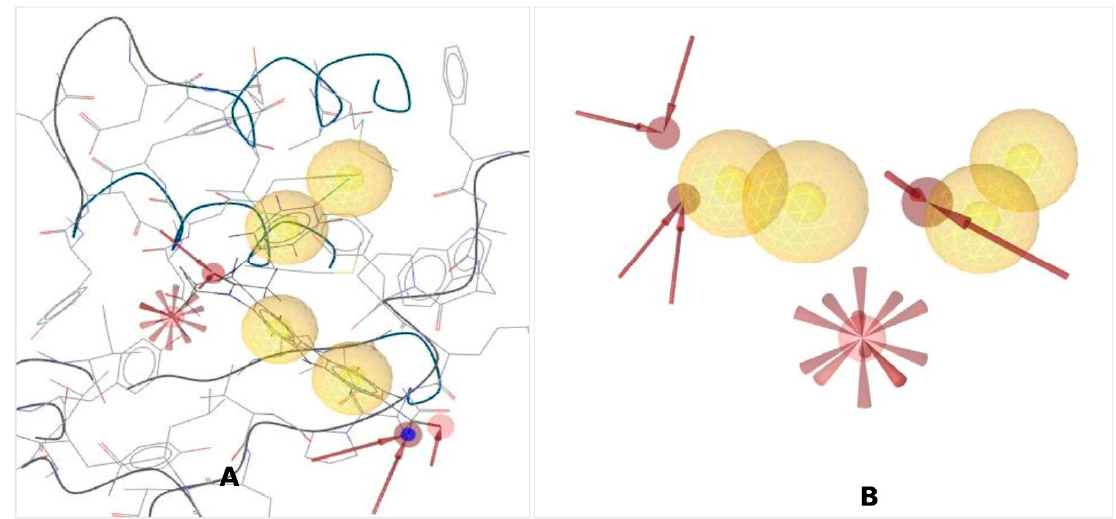
Figure 1. Representing a structure-based pharmacophore model generated from the PDB ID: 4BJX in complex with the attached ligand (PDB ID: 73B). ( A ) Generated features and protein structure ( B ) pharmacophore features without protein chain. There are four hydrophobic interactions ( ), red arrows ( ) indicating H-bond acceptors, and one red star ( ) depicting negative ionizable groups.